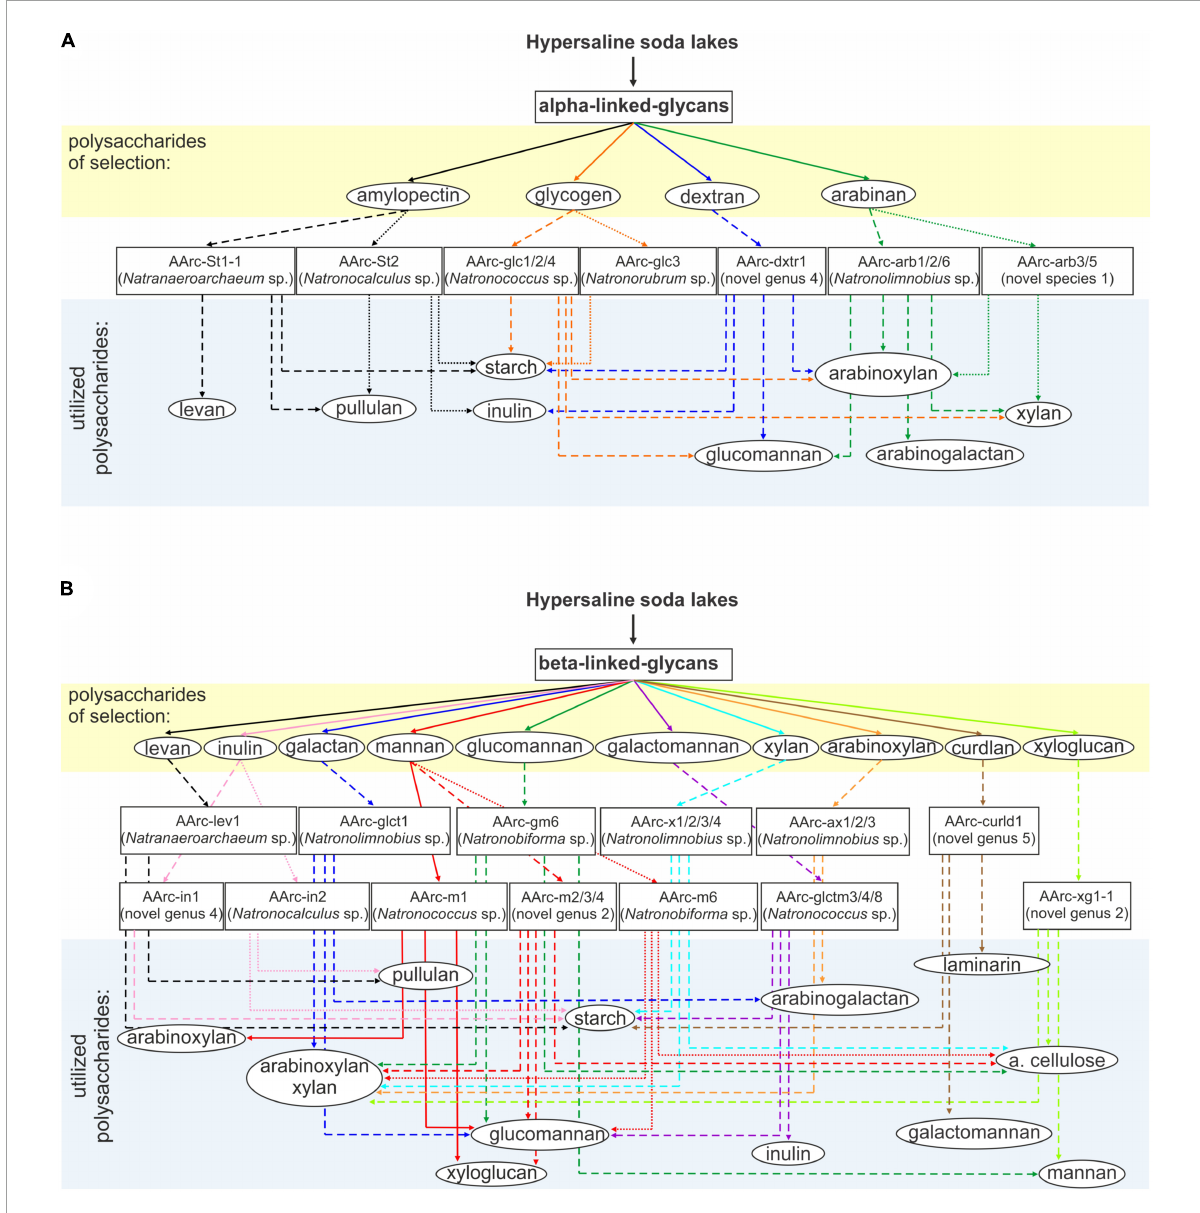
FIGURE2 Schematic representation of selective enrichments of natronoarchaea from hypersaline soda lakes on (A) alpha-bonded and (B) beta-bonded polysaccharides. Assignment to the novel genus was based on protein sequence-based phylogenomic analysis and 16S rRNA gene sequence identity values (for strain AArc-arb3/5 only 16S rRNA gene sequence identity values were used).